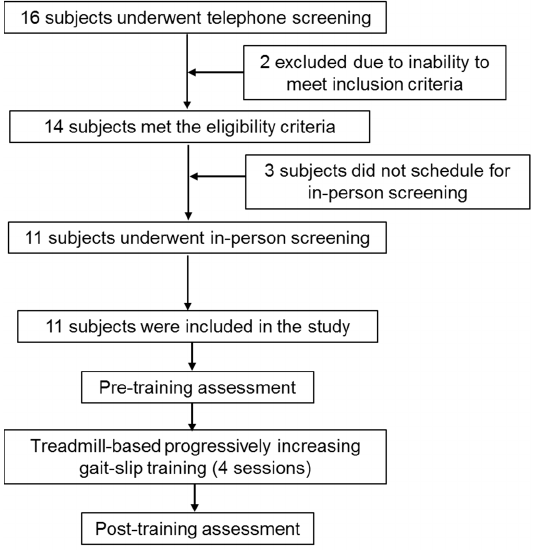
Figure 1. CONSORT flowchart summarizing participant recruitment, screening, and training for the data presented in this manuscript.